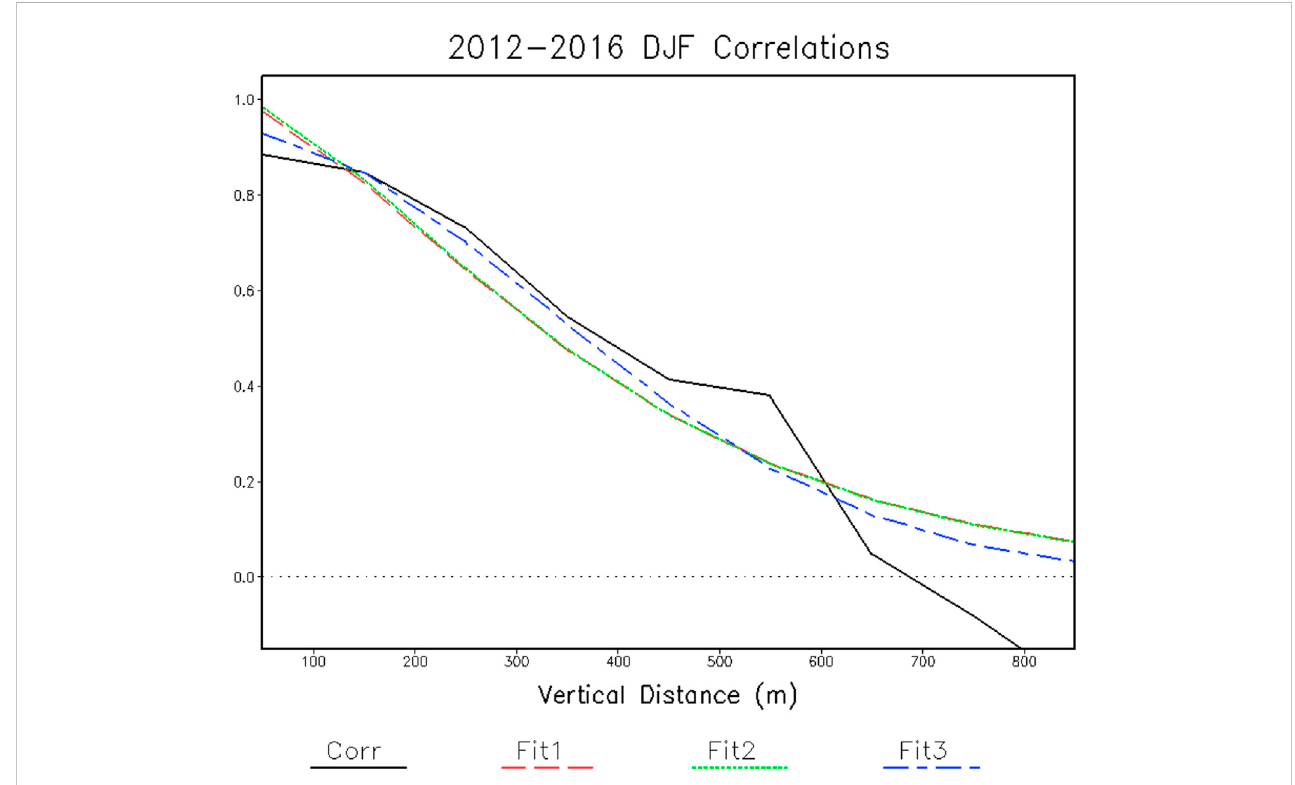
FIGURE 3 Snow depth correlations as a function of vertical separation distance. The observed correlations, Corr, and the indicated model fi ts are shown.